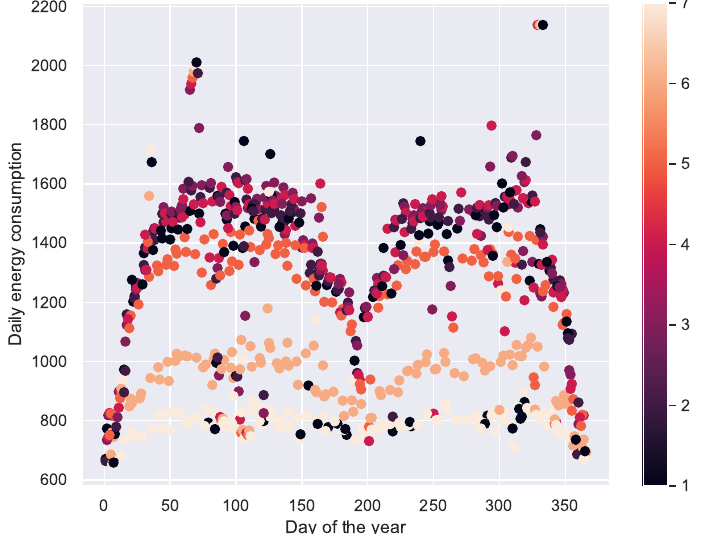
Figure 23. Incidence of the day of the year and the day of the week in energy consumption. 1 = Monday, 2 = Tuesday,